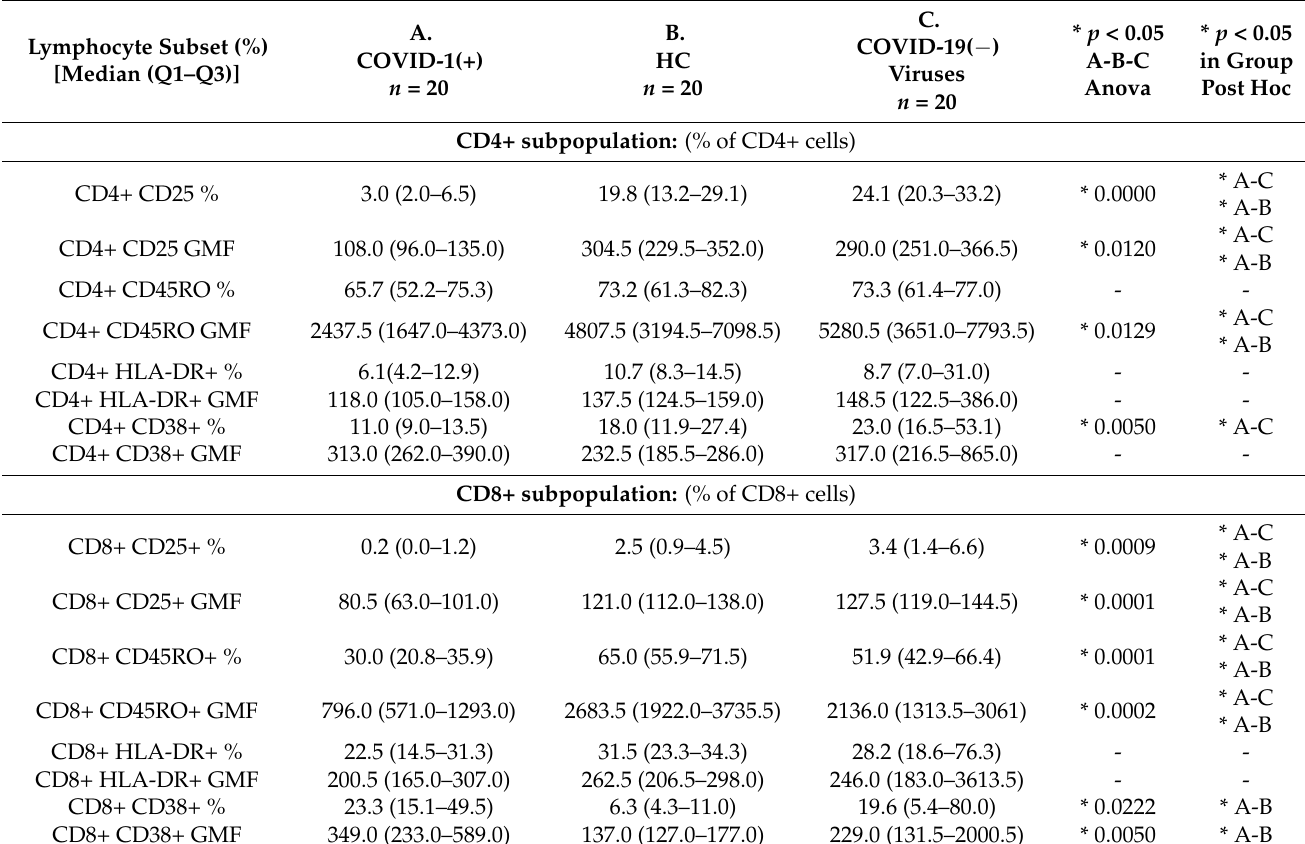
Table 4. Differences of CD4+ and CD8+ lymphocytes T with expression of CD25+, CD45RO+, HLA-DR+ or CD38+ between patients: with positive COVID-19 test—group A, control group (HC)—group B and group with other virus infections with negative COVID-19 test—group C. Data expressed as median of percentage or geometric mean fluorescence (GMF) intensity